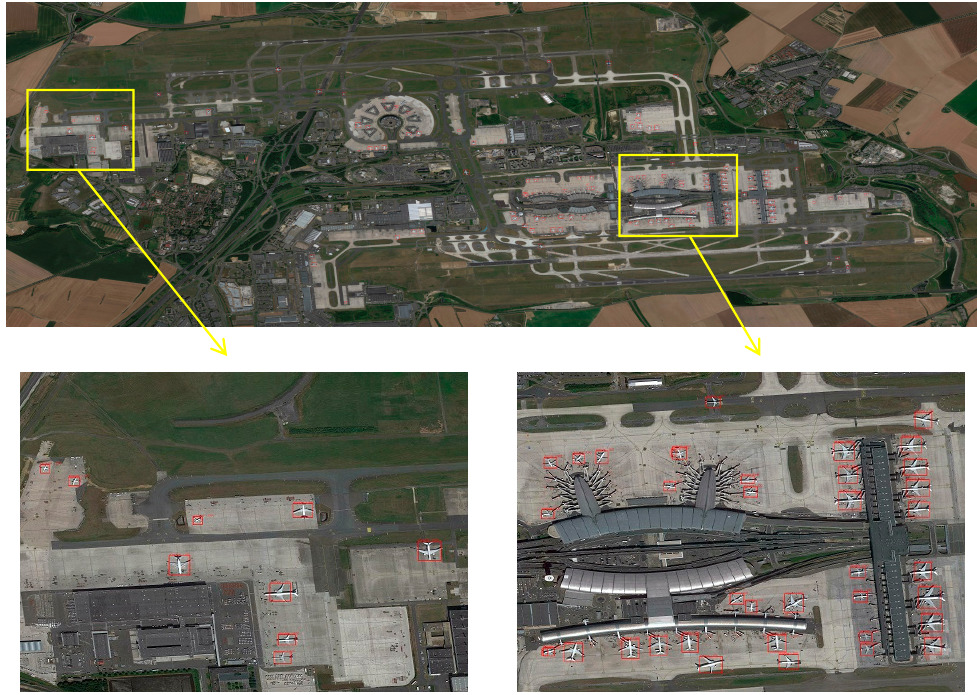
Figure 11. Detection results of our method in large range HRS imagery.